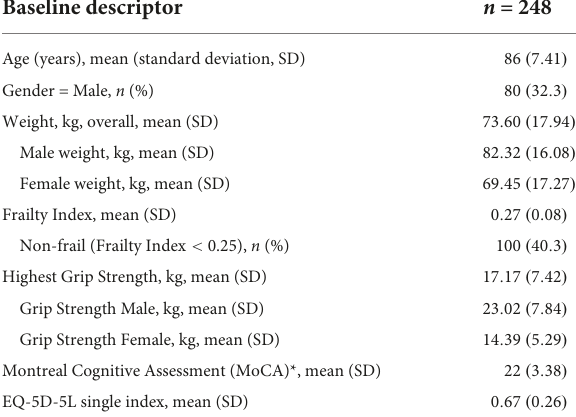
TABLE 1 Baseline characteristics of all trial participants.